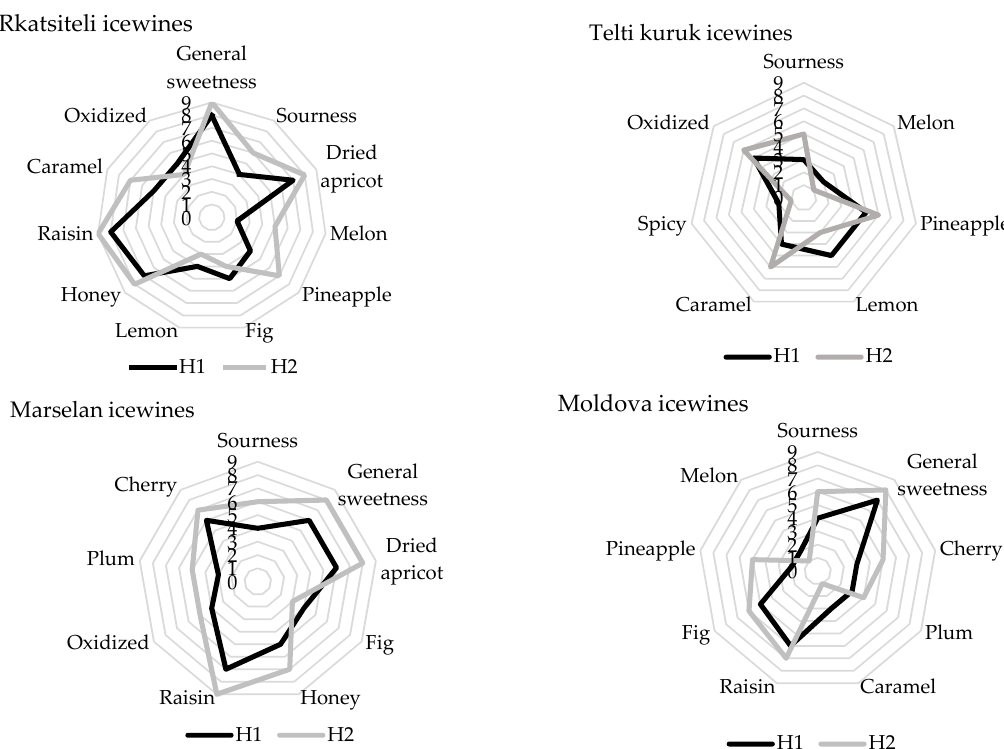
Figure 1. The intensity of sensory descriptors found in icewines made from four different varieties harvested at two different times. Sensory descriptors not shown on the plot are not significant according to a t -test.